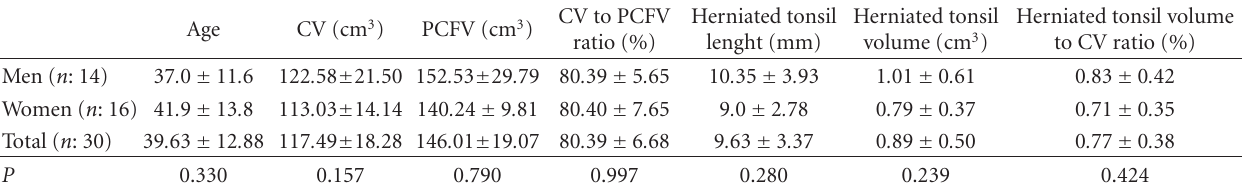
Table 3: Mean ( ± SD) values for age, CV, PCFV, and CV to PCFV ratio, herniated tonsillar length, herniated tonsillar volume, and herniated tonsillar volume to CV ratio for both sexes in the CMI group.